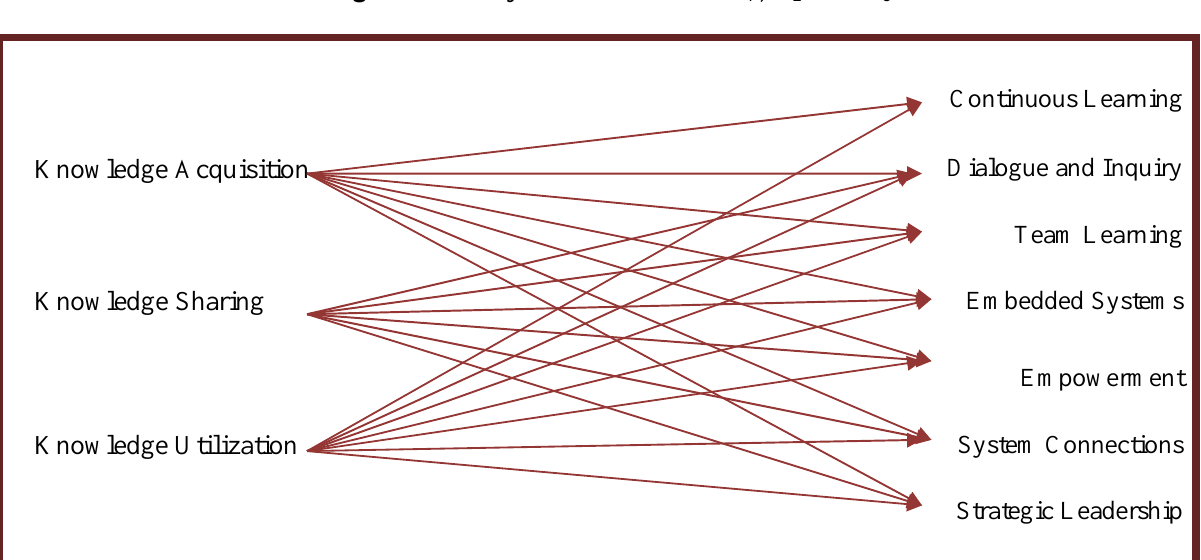
Fig.1. Summary of the results of H